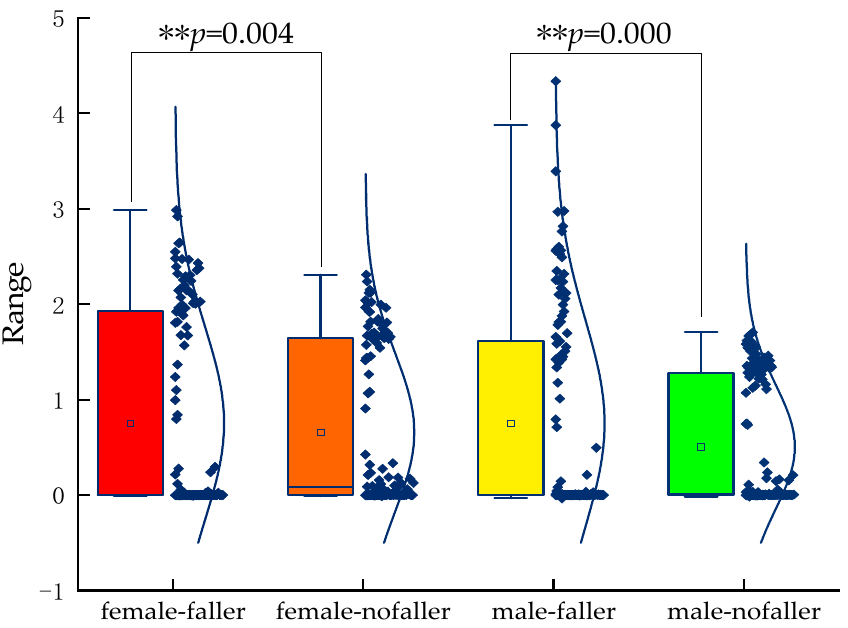
Figure 4. Statistical differences between groups. ** denotes significance ( p < 0.005).